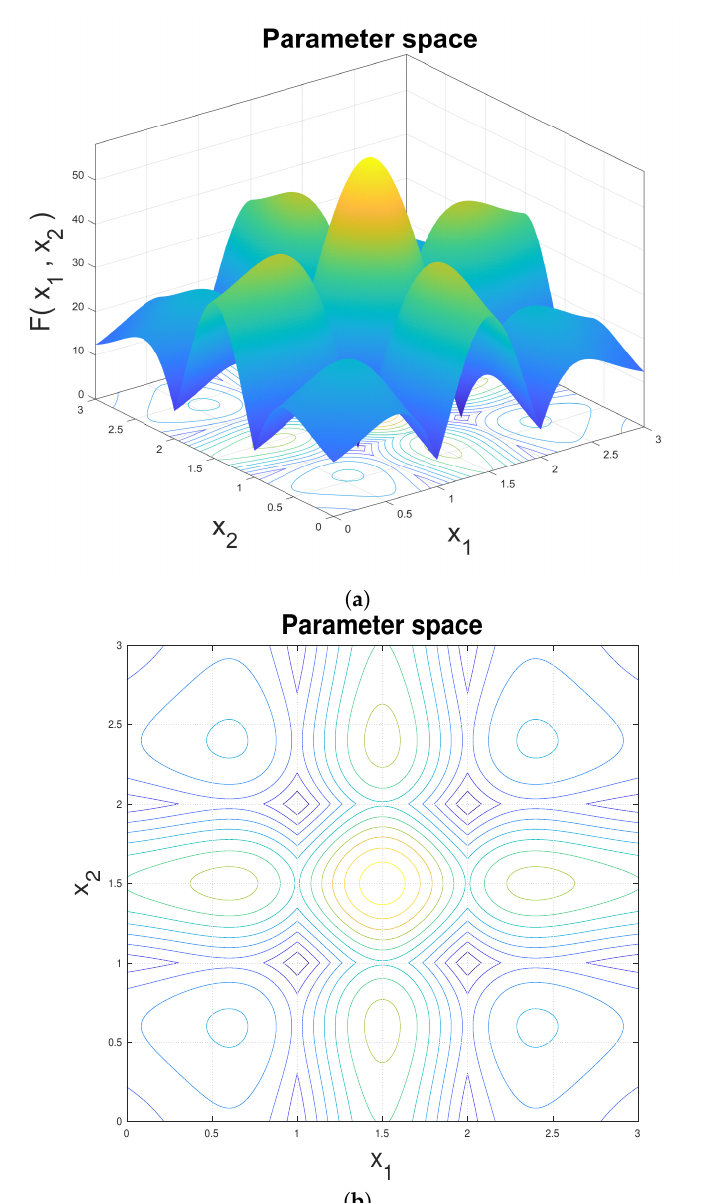
Figure 15. Objective function: ( a ) 3D plot; ( b ) 2D